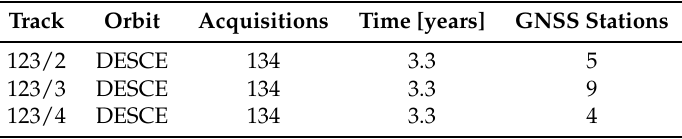
Table 2. North Anatolian Fault